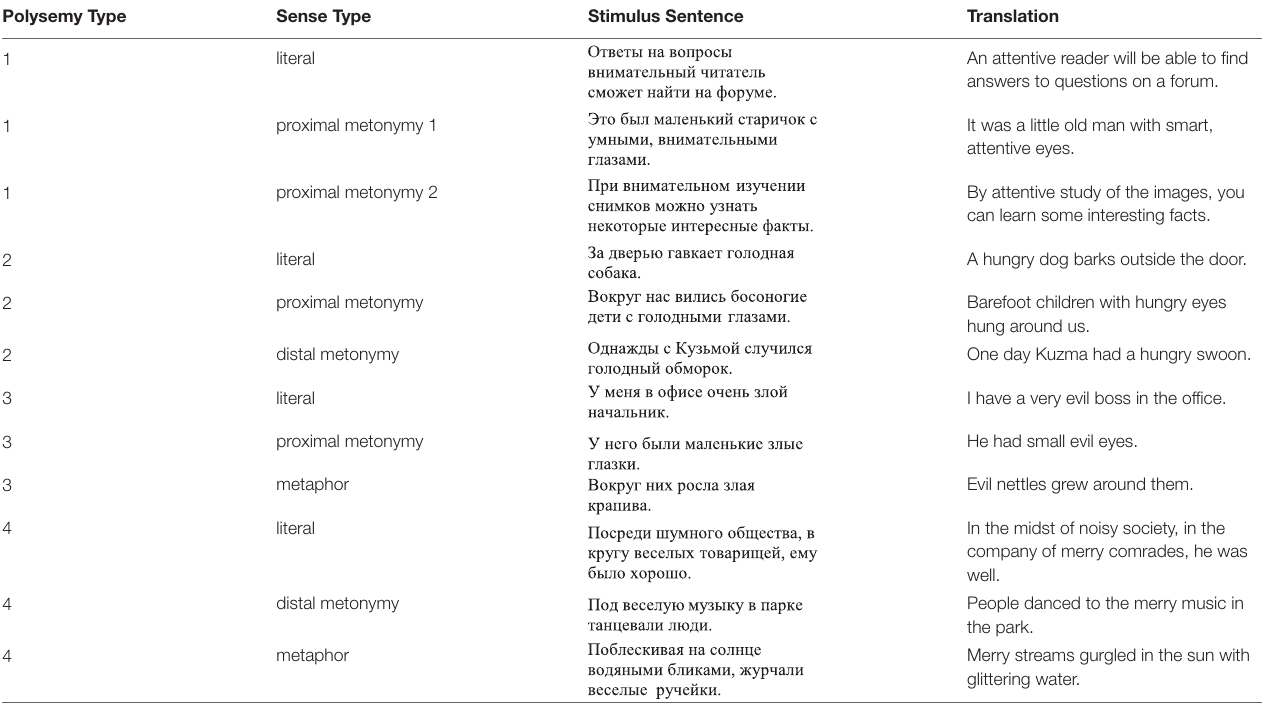
TABLE 1 | Sample sentences for each of the four types of polysemy (one sentence per sense). Polysemy Type